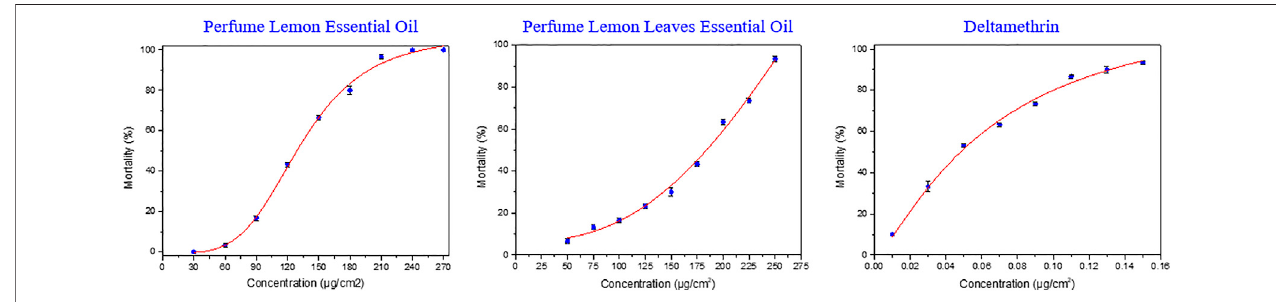
FIGURE 6 | Toxicity curve of the two essential oils against Ae. albopictus